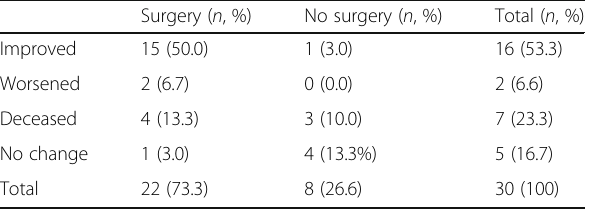
Table 3 Progress of patients admitted with